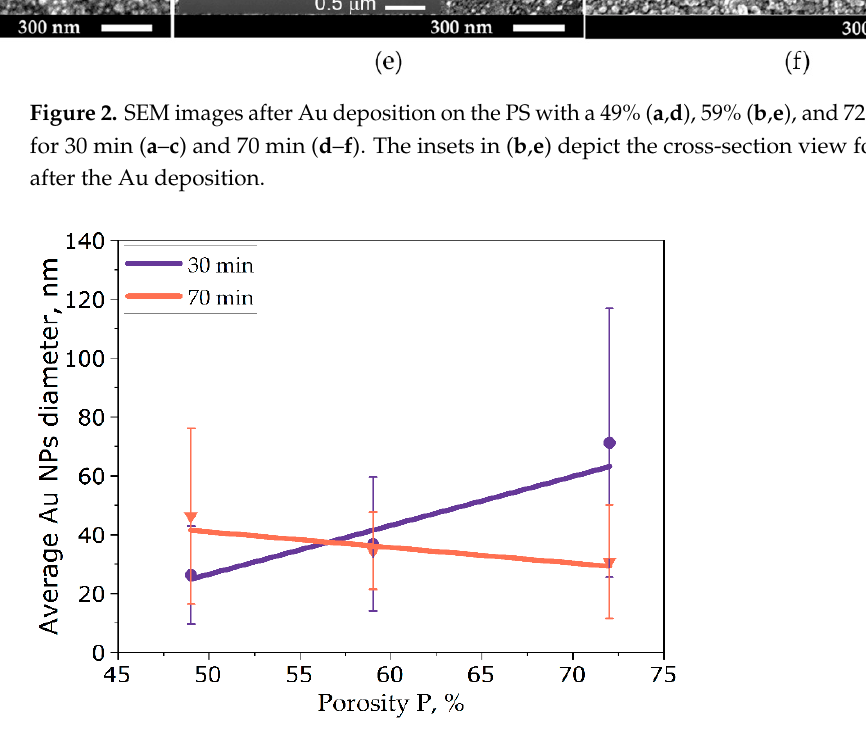
Figure 3. Evolution of the mean Au NP diameter as a function of the meso-PS porosity for different gold deposition times.